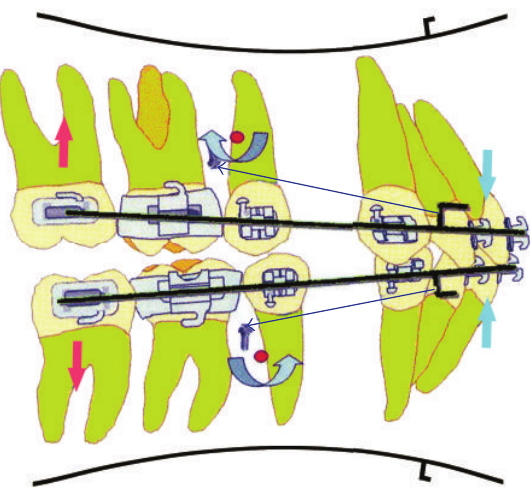
Figure 2: Intrusive force on posterior teeth causing posterior open bite and anterior deep bite.